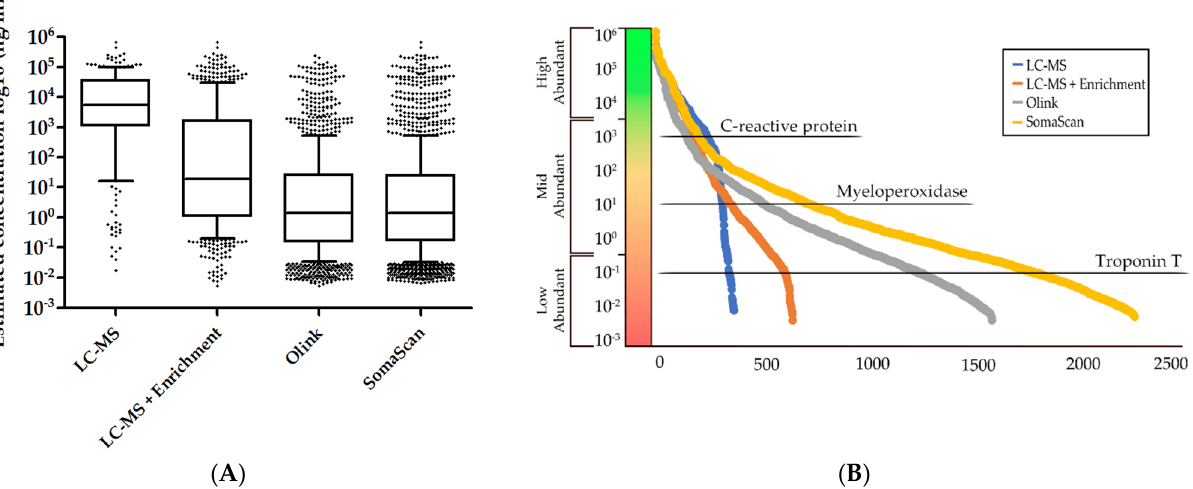
Figure 2. The estimated plasma protein concentrations from the publicly available Peptide Atlas build (Human Plasma 2021-07, accessed on 1 December 2021) [24] was used to compare the number of quantifiable protein from LC-MS analysis (with and without affinity enrichment) with proteins that were available in the Olink and SomaScan assays. Note: Not all the proteins were associated with an estimated plasma protein concentration in the Peptide Atlas build. ( A ) Boxplot of the estimated protein concentrations for each of the analytical techniques displaying the distribution of quantifiable proteins. The whisker boundary is defined as the 10th–90th percentile. ( B ) Graphical representation of the diversity in the number of quantifiable proteins in relation to the estimated protein concentrations with known cardiovascular biomarkers as examples of the dynamic range in plasma. While the curves are initially similar, it is evident that the SomaScan and Olink are able to quantify far more mid-and low-abundant proteins compared to LC-MS analysis even with the application of affinity enrichment. LC-MS analysis using affinity enrichment is able to sporadically quantify proteins in the same lower range as SomaScan and Olink. Dataset references: LC-MS: [39]; LC-MS + Enrichment: [40]; Olink: